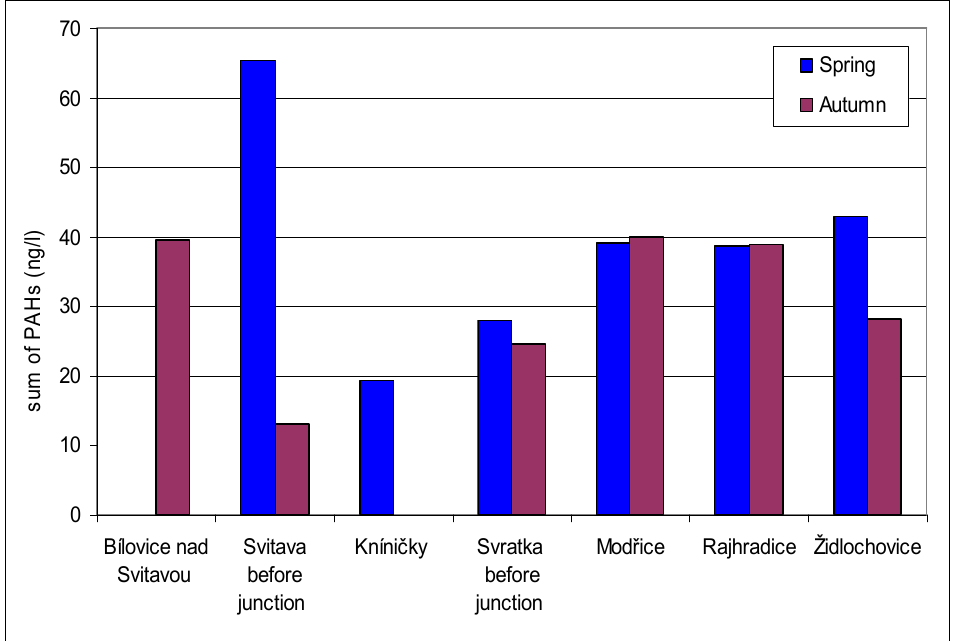
Figure 8. PAH content (in ng·L -1 ) in SPMD at monitored